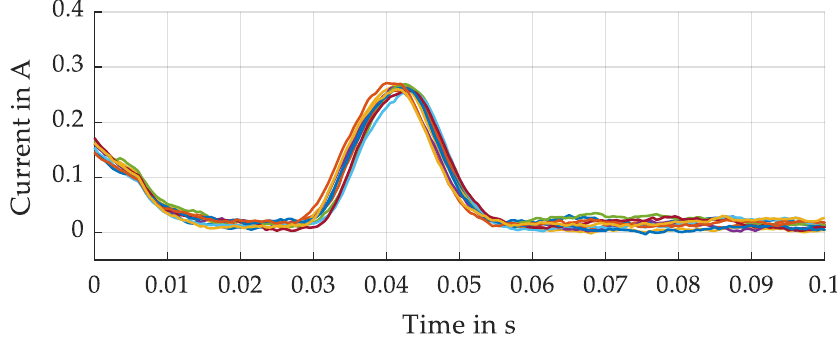
Figure 13. Measured current signals for all measurements. Figure 17. Measured pressure signals in the relief system for all Figure 17. Measured pressure signals in the relief system for all measurements.